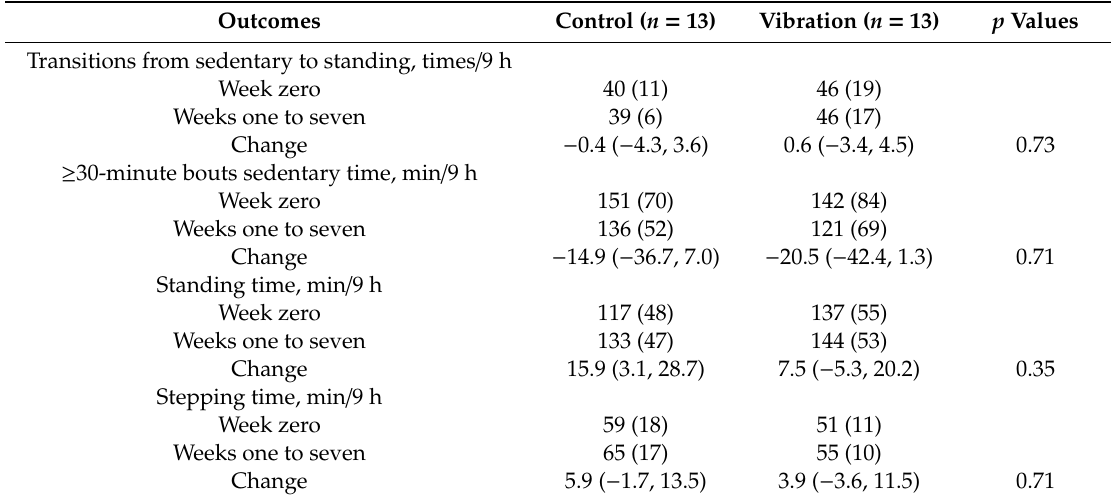
Table 2. Changes in exploratory behavioral outcomes during the eight-week intervention period. Outcomes Control ( n = 13) Vibration ( n = 13) p Values Transitions from sedentary to standing, times / 9 h Week zero 40 (11) 46 (19) Weeks one to seven 39 (6) Change − 0.4 ( − 4.3,